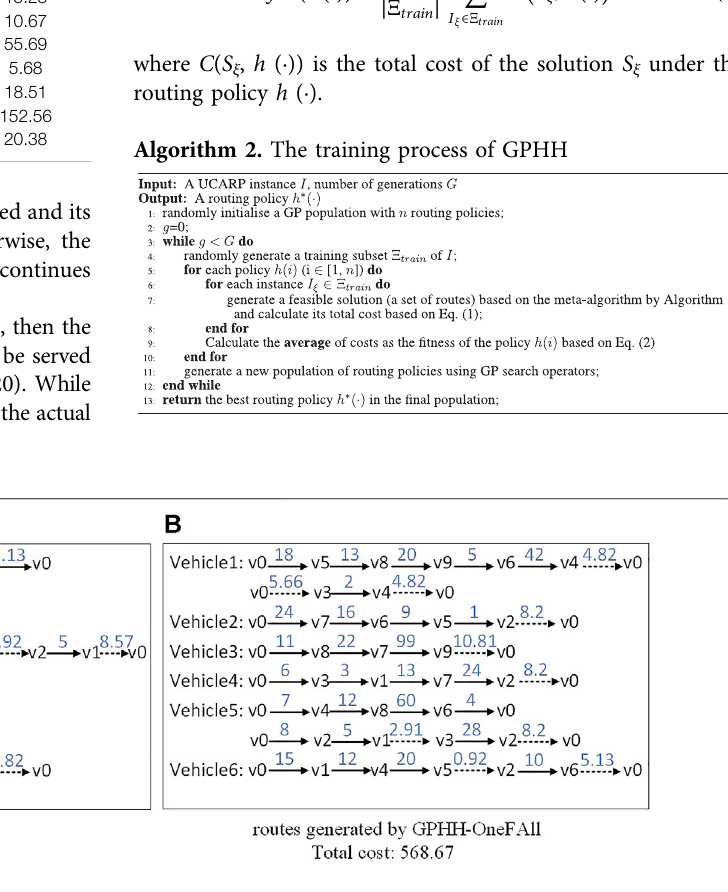
FIGURE 2 | Examples of the routes generated by (A) GPHH-Re and (B) GPHH-OneFAll on the sampled ugdb 13 instance in Table 5 . The solid arrow connecting two vertices ( vi , vj ) means that ( vi , vj ) is a task and the vehicle travels from vi to vj to serve it, while the dotted arrow connecting two vertices ( vi , vj ) means that the vehicle travels from vi to vj followingthe shortest path betweenthesetwovertices withoutserving any tasks. The number above thesolid arrow represents the serving cost,and the number above the dotted arrow represents the actual traversal cost of the shortest